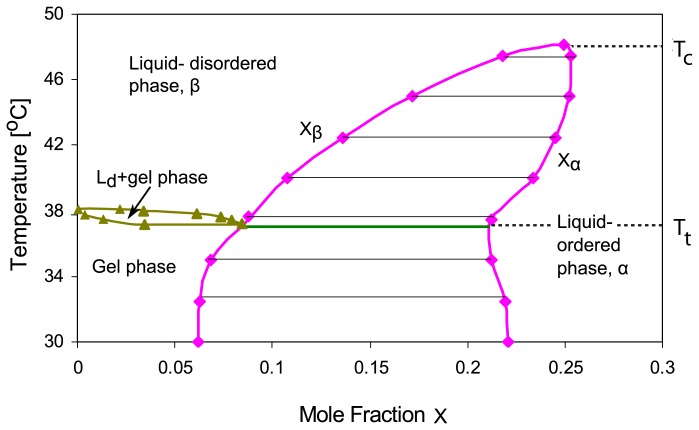
Generic phase diagram for mixed membranes consisting of cholesterol and a single phospholipid. The variable Xa represents the mole fraction of cholesterol; the phase boundaries have been deduced from experiments on the phospholipid DPPC [8]. The fluid-fluid coexistence region between the liquid-ordered phase α on the right and the liquid-disordered phase β on the left is bounded by the two binodal lines Xa = Xa,β(T) and Xa = Xa,α(T), which meet at the critical point with T = Tc. The horizontal broken lines represent tie lines within the two-phase coexistence region. The triple point temperature is denoted by Tt.